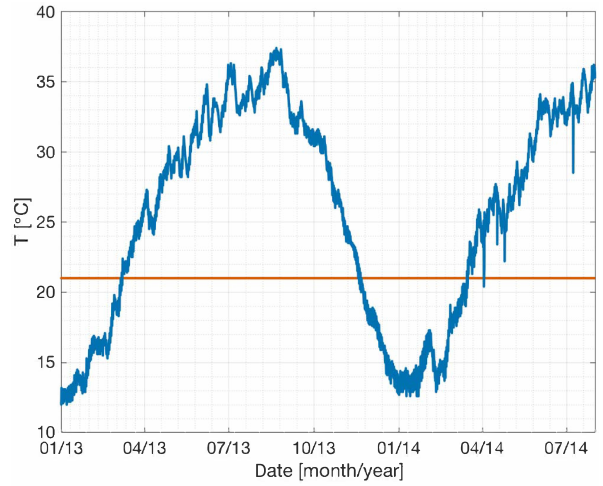
Figure 5. Seasonal variation of the data logger energy card temper- ature during 2013 and 2014. This temperature is measured every minute and we assumed that it is similar to the oscillator tempera-